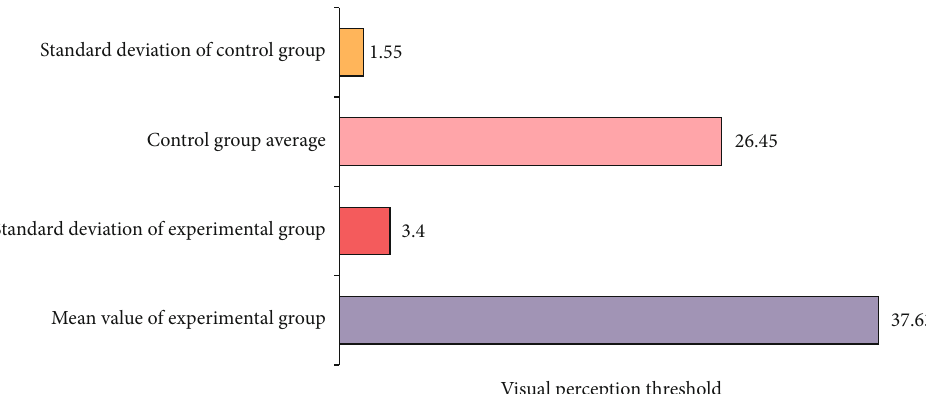
Figure 2: Visual perception threshold of Tai Chi.